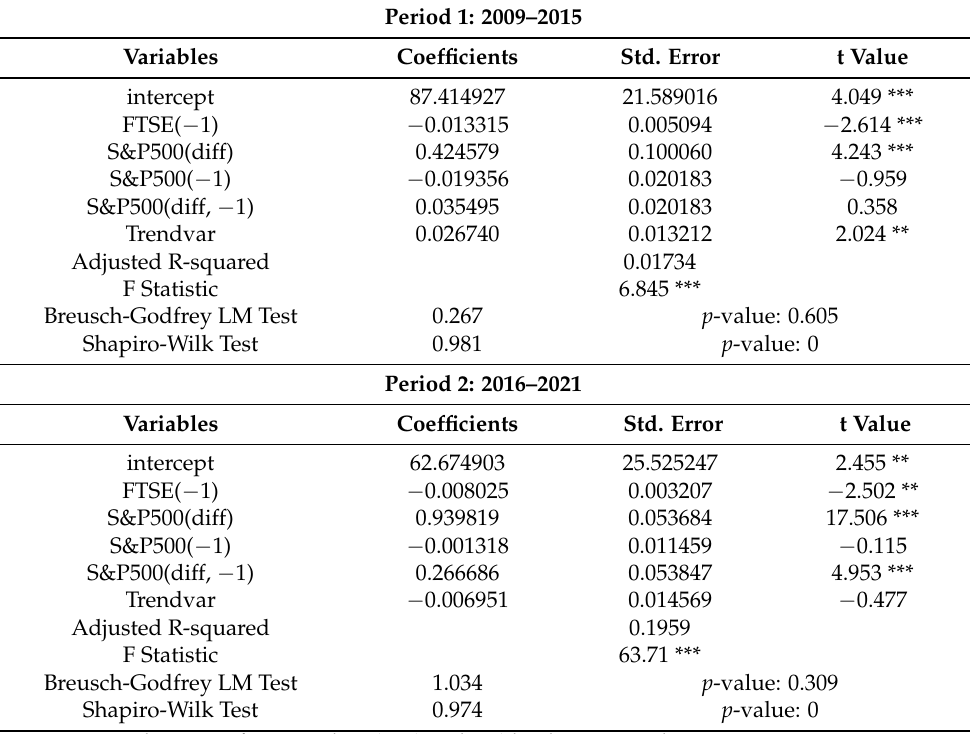
Table 4. Dynamic analysis using